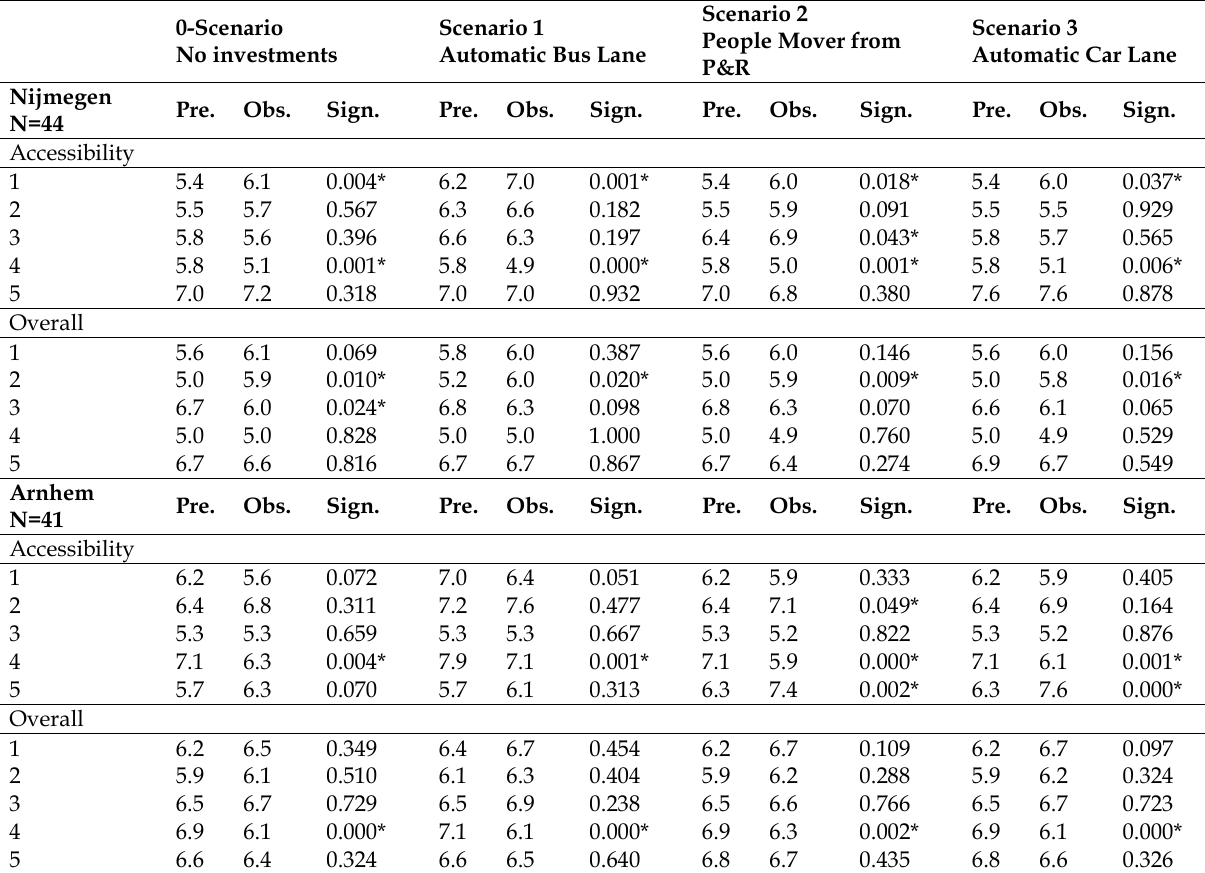
Table 4. T-test for model validity based on corrected scores